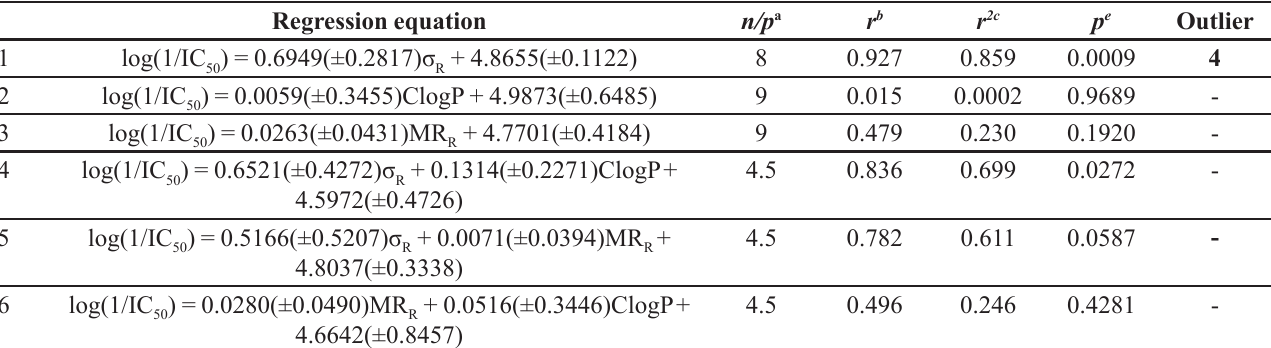
TABLE III - QSAR models with statistical parameters. Regression equation